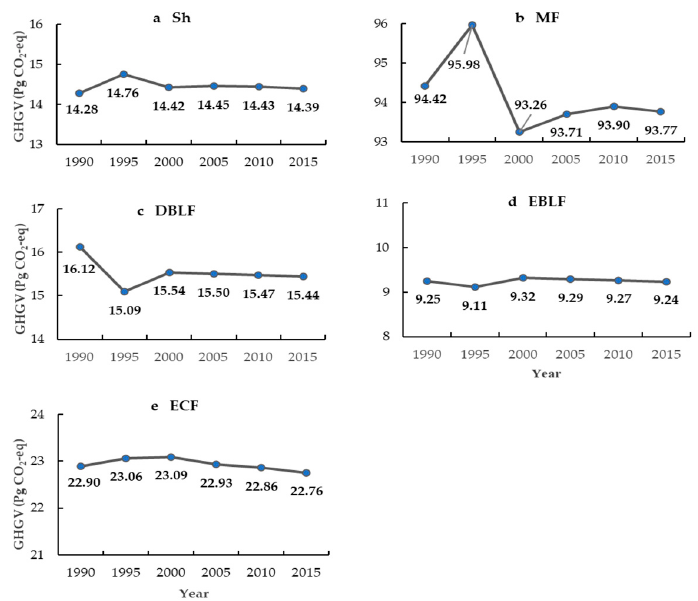
Figure 4. Changes of greenhouse gas value (GHGV) in China’s various forest ecosystems during1990–2015. The acronyms in ( a – e ) are Shrubbery (Sh), Evergreen coniferous forest (ECF), Mixed forest (MF), Evergreen broad-leaved forest (EBLF), and Deciduous broad-leaved forest (DBLF).